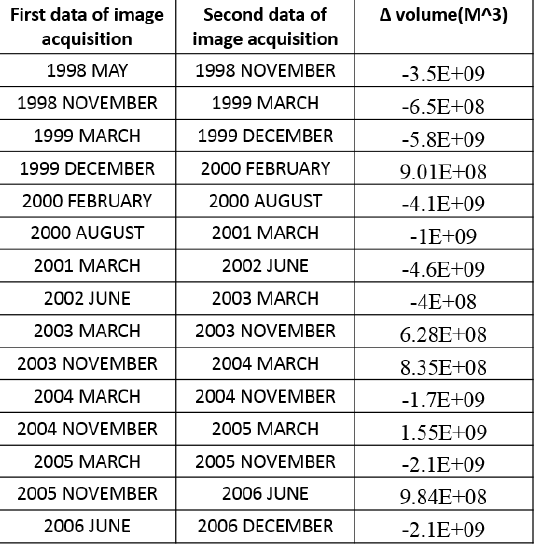
Table 3. Computed volume change.